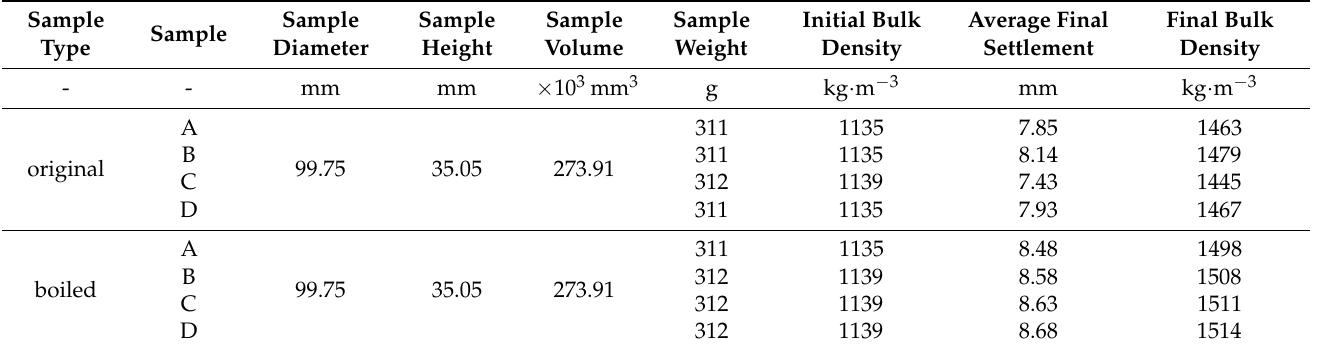
Table 5. Parameters of direct shear